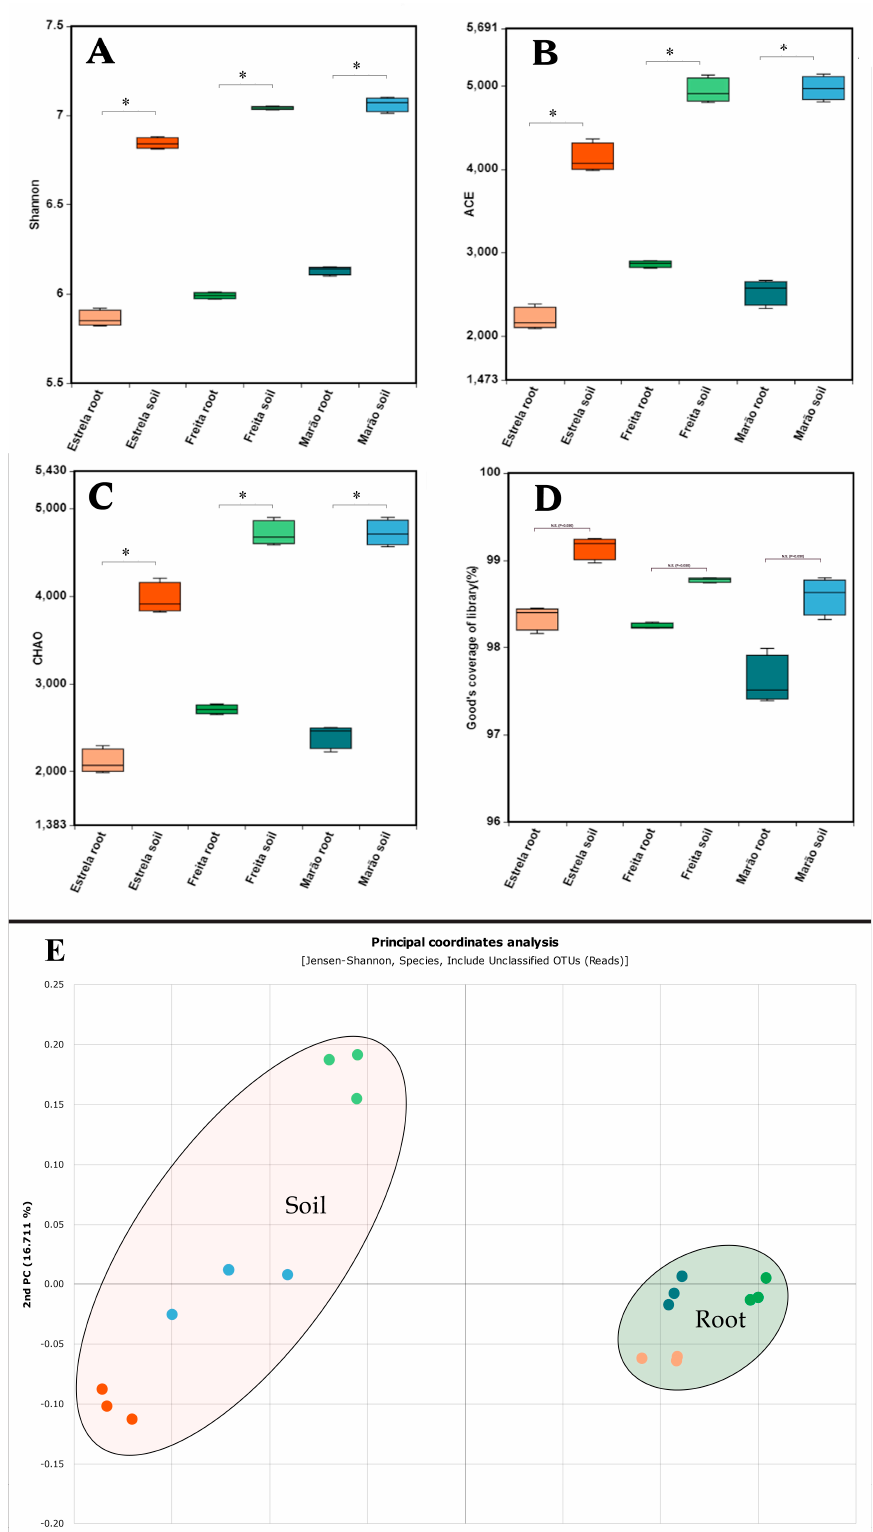
Figure 3. Analysis of the α - and β -diversity of bacterial communities. ( A ) Shannon–Wiener index, ( B ) ACE index, ( C ) Chao index, ( D ) Good’s coverage index, and ( E ) PCoA showing the distribution of bacterial communities based on their species composition. *: indicates significant differences (Anova; Mann–Whitney pairwise comparison; Bonferroni-corrected p values; p <